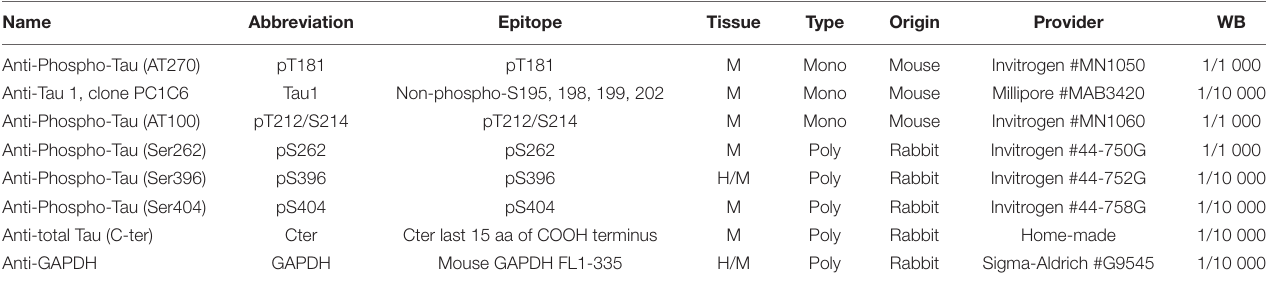
TABLE 2 | List of primary antibodies used for biochemical detection of Tau proteins on Western blot.